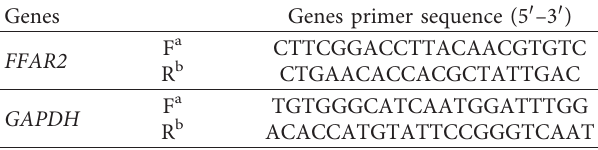
Table 1: RT-PCR primer